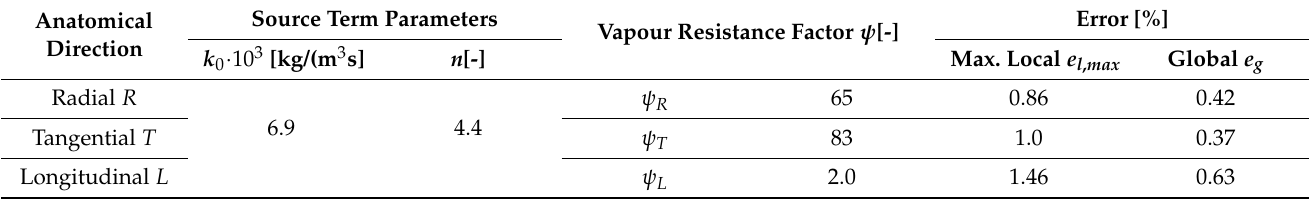
Table 4. Model coefficients and matching errors for pine.